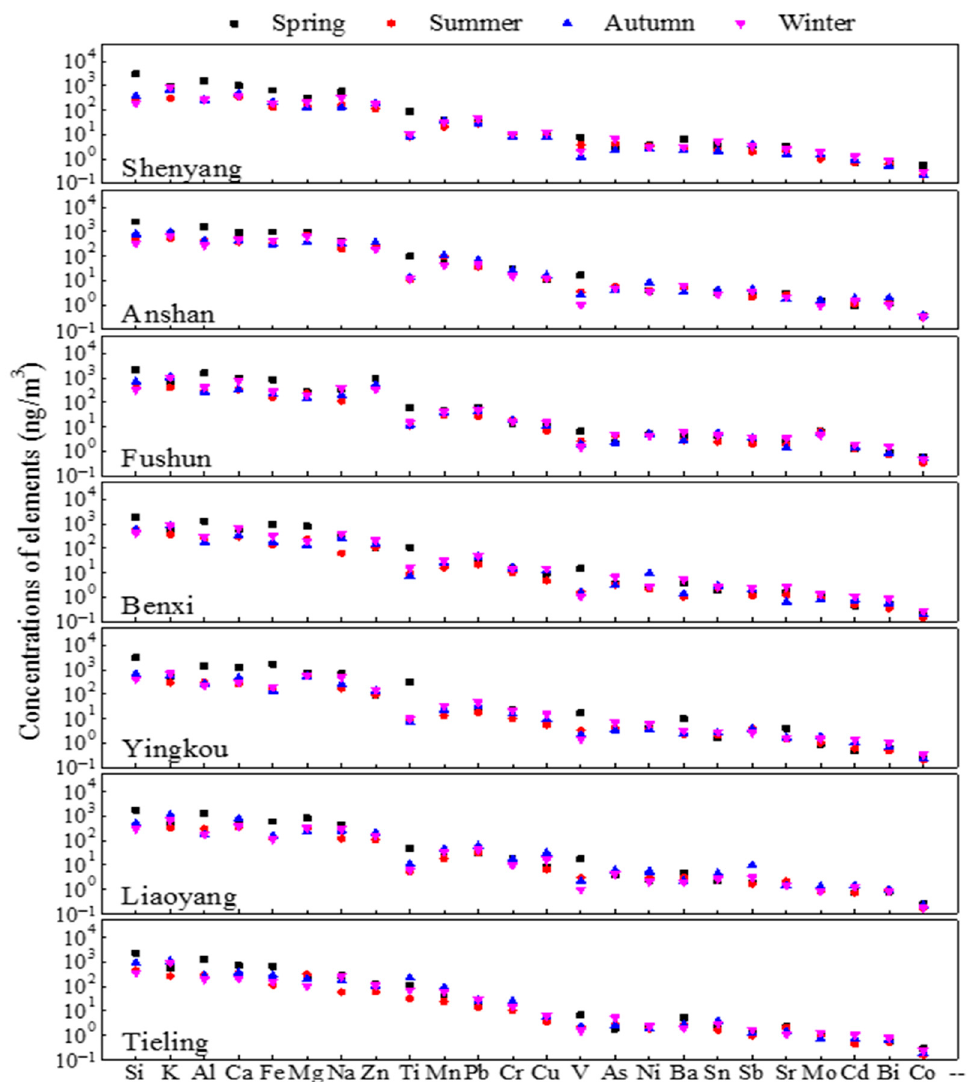
Figure 4. The mean concentrations of total 24 PM 2.5 elemental components in different seasons at seven cities, the y ‐ coordinate is the logarithmic coordinate.